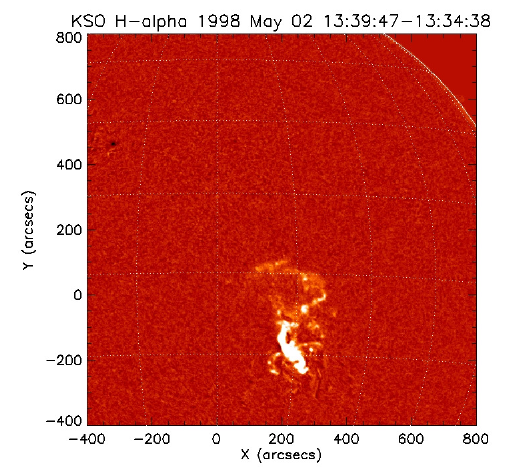
Figure 10: Still from a movie – An animation of the Moreton wave of 1998 May 2 observed in H α base difference images at Kanzelh¨ohe Solar Observatory. (To watch the movie, please go to the online version of this review article at http://www.livingreviews.org/lrsp-2015-3